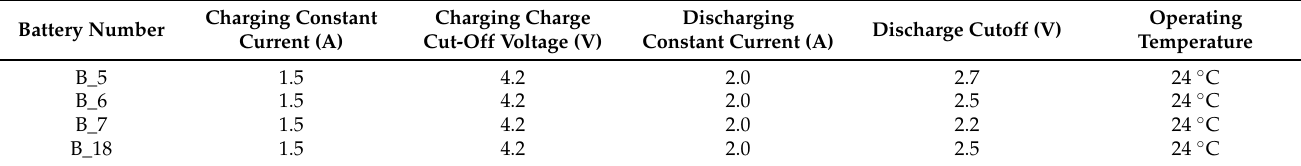
Table 2. Experimental specifications for the battery